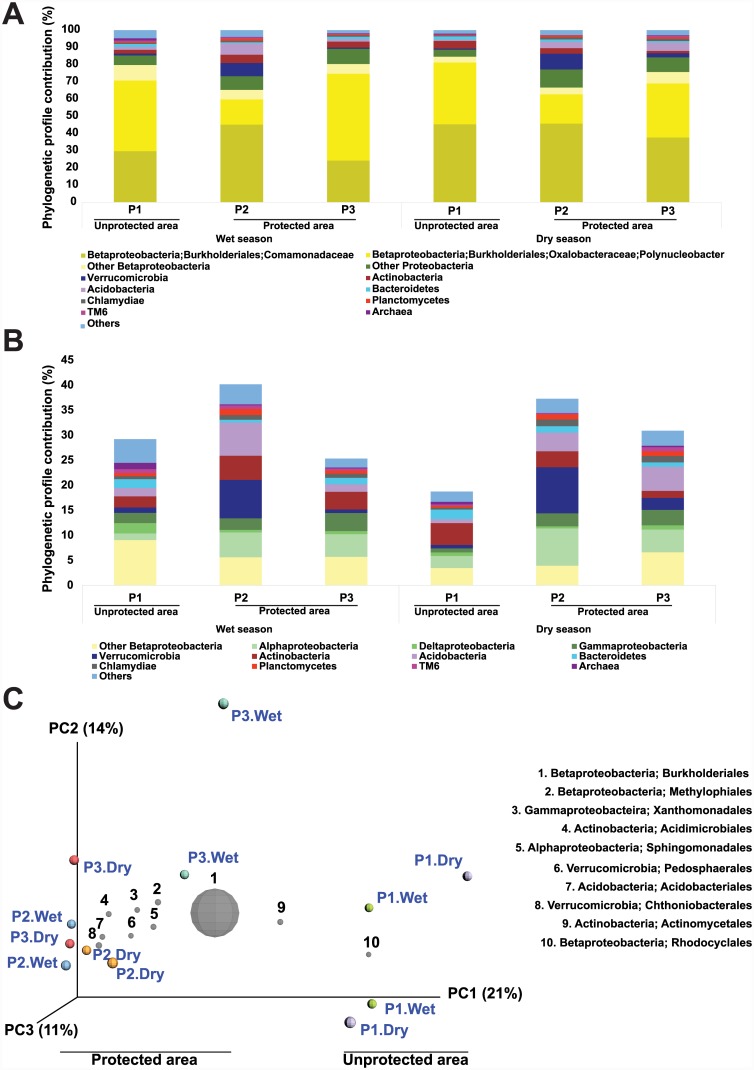
Taxonomic classification based on sequence analysis of 16S rRNA genes detected in Paraguaçú River water samples obtained from three sampling points (P1, unprotected area; P2 and P3, protected area) during both wet and dry seasons.A) Total relative abundance of taxonomic groups (kingdom, phylum, class, family, and genus). B) Relative abundance of taxonomic groups (kingdom, phylum, and class) without the contribution of the Comamonadaceae family and Polynucleobacter genus. C) Principal coordinates analysis (PCoA) of relative abundances of taxonomic groups (at the order level). PCoA plot of community similarities (unweighted UniFrac distance matrices). The relative abundance of each taxonomic level (kingdom, phylum, class, and order) for each sample and their taxonomic assignments were determined by QIIME 1.7.0 software with the Greengenes database (May 2013).